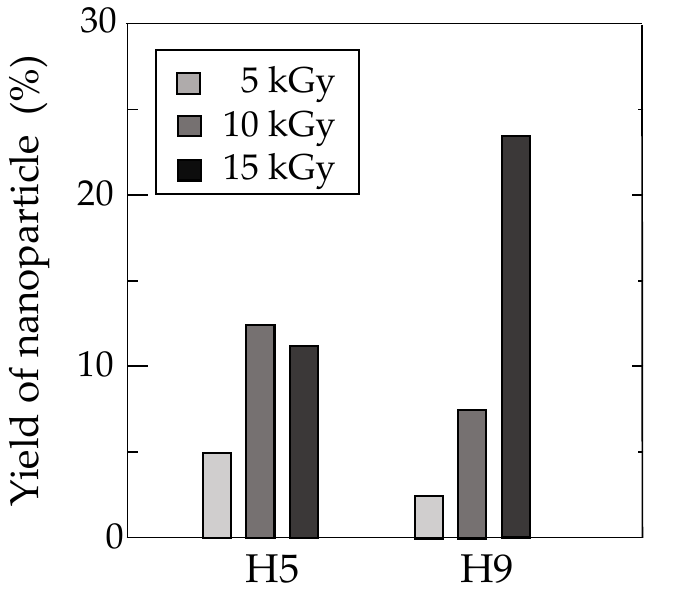
Figure 3. Peptide nanogel yield from 0.1 wt.% peptide aqueous solution as a function of the absorbed radiation dose.